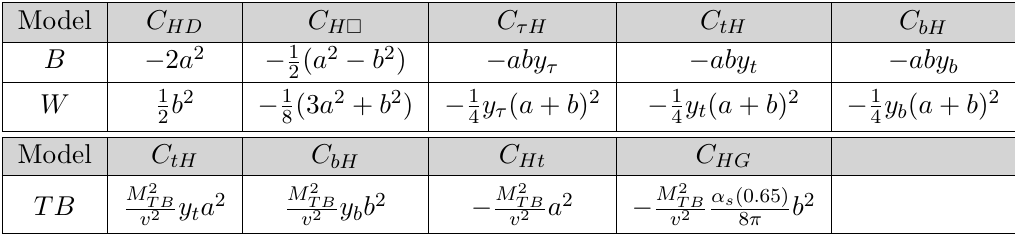
, y and y denoting the top, bottom and tau Yukawa t b τ denoting the strong coupling. The s